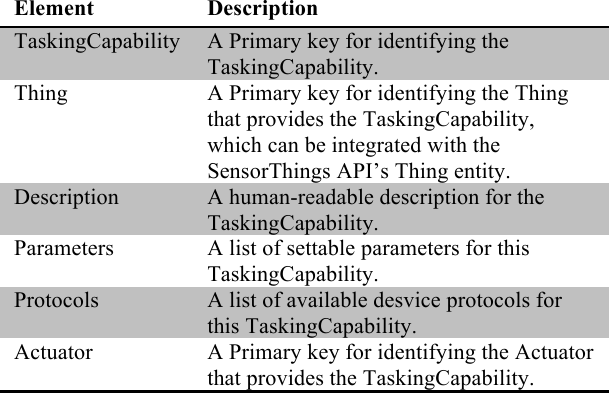
Table 1. The elements of tasking capability